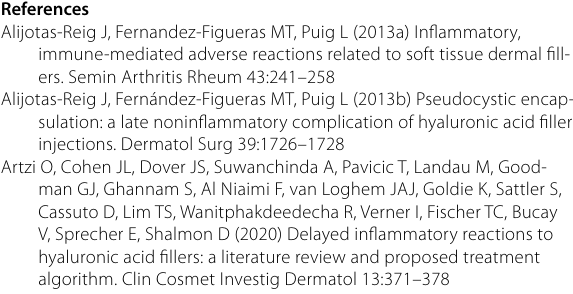
algorithm. Clin Cosmet Investig Dermatol